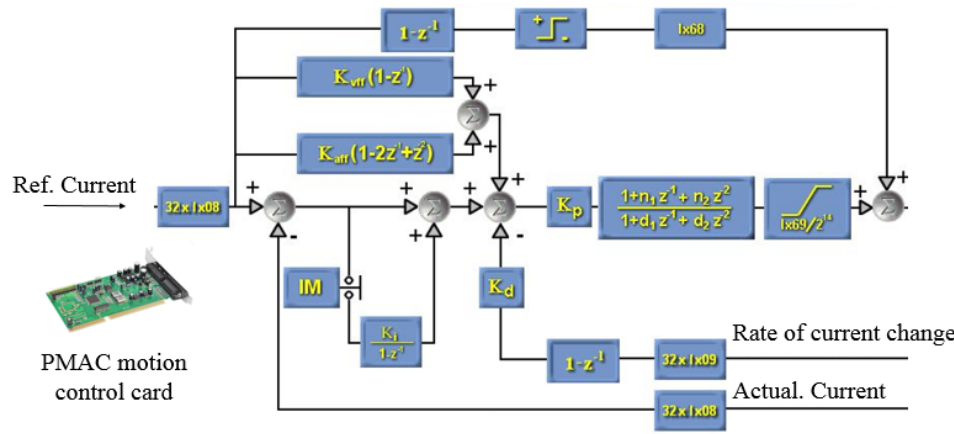
Figure 7. Block diagram of the force control system.